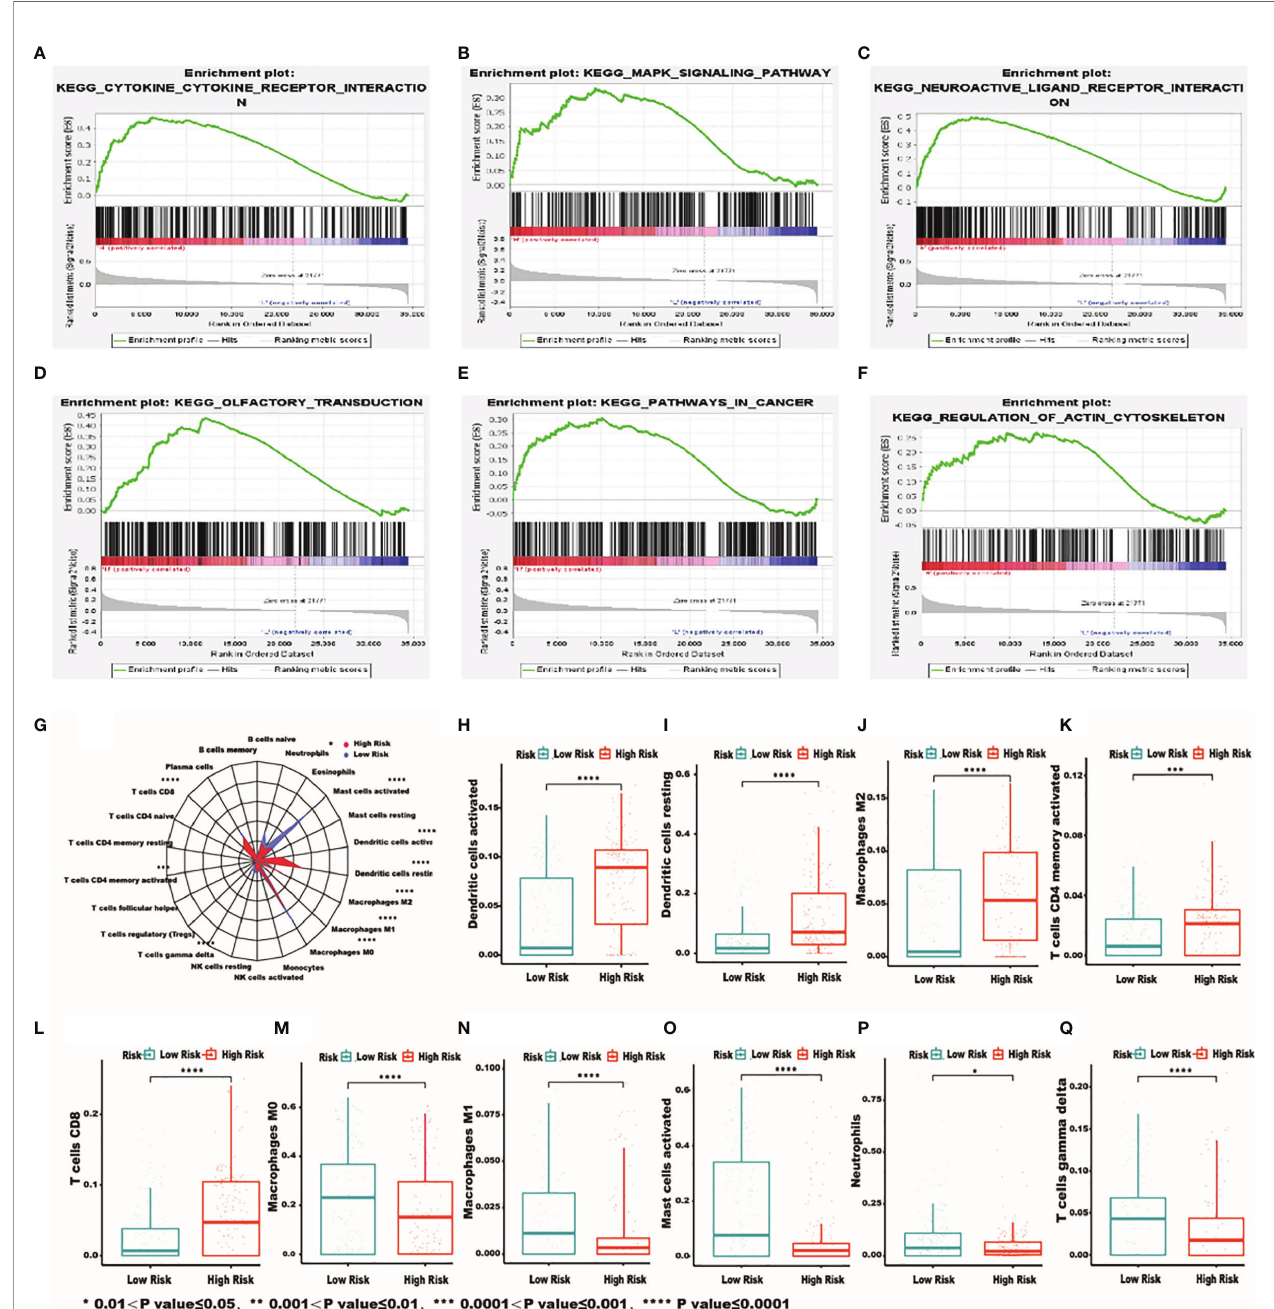
FIGURE 6 | The most signi fi cantly enriched KEGG pathways between high- and low-risk patients. KEGG: cytokine-cytokine receptor interaction (A) ; MAPK signaling pathway (B) ; neuroactive ligand receptor interaction (C) ; olfactory transduction (D) ; pathway in cancer (E) ; regulation of actin cytoskeleton (F) . Relationships between the IRRSM and immune cells. The relationships between IRRSM and immune cells in fi ltration: radar plot (G) ; dendritic cells activated (H) ; dendritic cells resting (I) ; macrophages M0 (J) ; T cells CD8 (K) ; B cells naive (L) ; macrophages M1 (M) ; macrophages M2 (N) ; mast cells activated (O) ; mast cells resting (P) ; T cells gamma delta (Q)